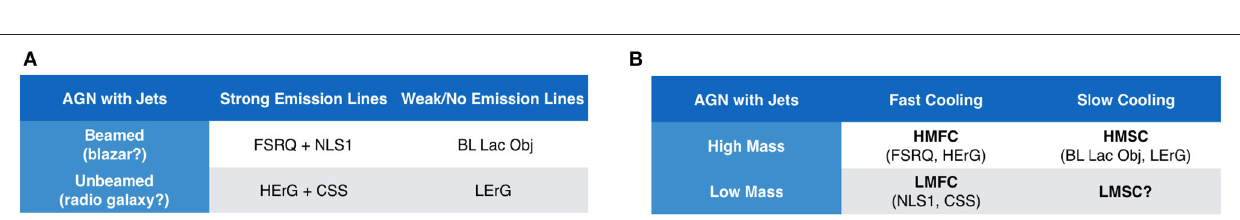
FIGURE 2 | Changing terms in the unification scheme. (A) The updated Urry and Padovani’s scheme. (B) Physical unification